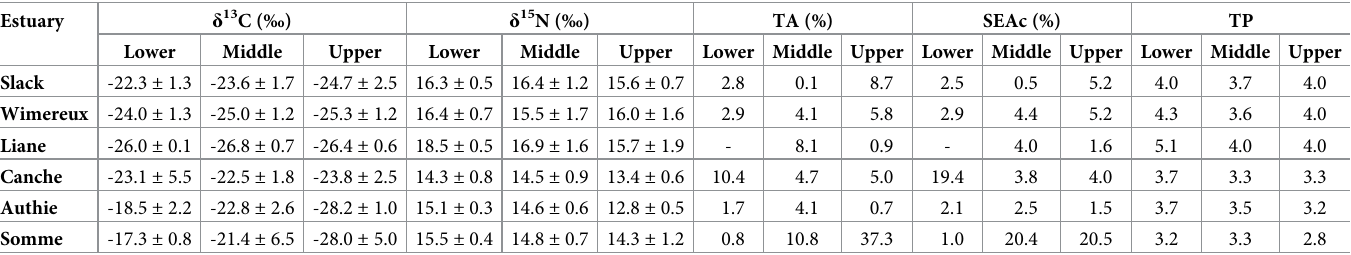
Table 3. Isotopic metrics with mean ± standard deviation of δ 13 C and δ 15 N (‰) of European eels along salinity gradient (i.e. lower, middle and upper) in the six estuaries and total convex hull area (TA; %), corrected standard ellipse areas (SEAc, %), and trophic position (TP). Estuary δ 13 C